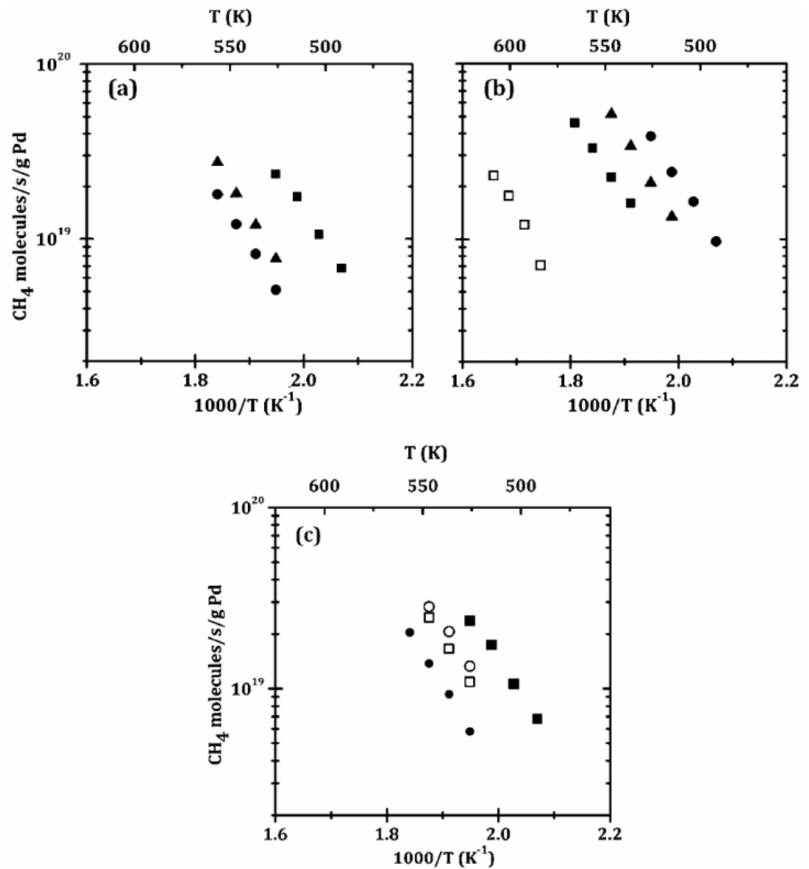
Figure 2. Steady-state, differential reaction rates for methane oxidation. ( a ) Rates on PdO/Al 2 O 3 after calcination to the following temperatures: ( (cid:4) ) 773, ( (cid:78) ) 973, and ( • ) 1073 K. ( b ) Rates on ZrO 2 − PdO/Al 2 O 3 samples after calcination to the following temperatures: ( (cid:3) ) uncalcined, ( (cid:4) ) 773, ( (cid:78) ) 973, and ( • ) 1073 K. ( c ) Rates on ZrO 2 − Pd/Al 2 O 3 , where ZrO 2 was deposited by ALD on the reduced catalysts, after calcination at ( (cid:3) ) 773 and ( ) 1073 K. Data for PdO/Al 2 O 3 calcined at ( (cid:4) (cid:35)